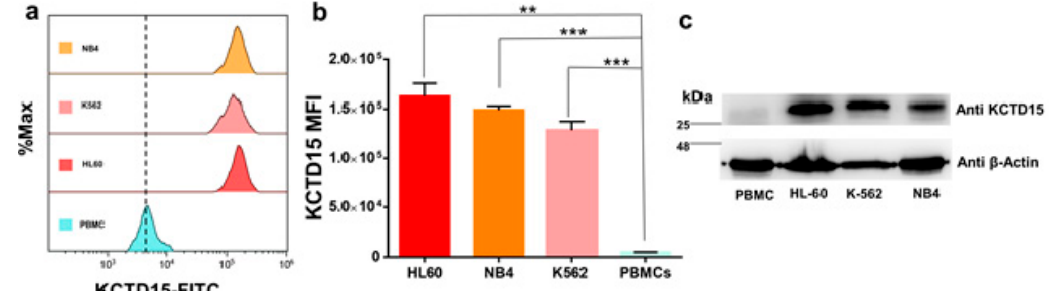
Figure 2. KCTD15 expression in the acute myeloid leukemia (AML) cell lines. ( a ) Overlay histogram showing the increased KCTD15 fluorescence intensity in NB-4, K562, and HL-60 cell lines when compared to peripheral blood mononuclear cells (PBMC). Histograms are normalized as a percentage of maximum count value (% Max) on the vertical axis. ( b ) Bar-plot displaying KCTD15 fluorescence intensity (in terms of mean of fluorescence and SD) in HL-60 (red), NB-4 (orange), and K562 (pink) compared to PBMC (light blue). ** p < 0.01, **** p < 0.0001, unpaired t -test. The error bar represents SD. ( c ) Western blot of KCTD15 protein in human AML in vitro model systems (HL-60, NB-4, and K-562), as well as PBMC. The number represents the molecular weight of the protein marker expressed in kDa. Experiments displayed in panels a–c were repeated twice with similar